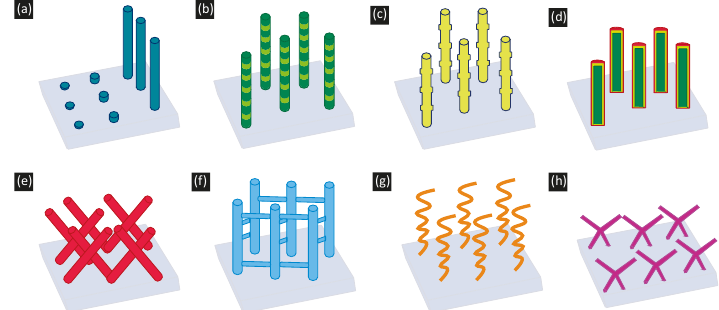
Figure 2. Schematics of the different magnetic nanostructures that can be grown using electrodepo- sition, described in the manuscript. ( a ) Nanodots and nanowires. ( b ) Nanostructured nanowires along the axial direction. ( c ) Geometrically modulated nanowires. ( d ) Nanowires modulated along the radial direction. ( e ) Interconnected nanowires using polycarbonate templates. ( f ) Interconnected nanowires using AAO templates. ( g , h ) Complex 3D structures combining electrodeposition and advanced